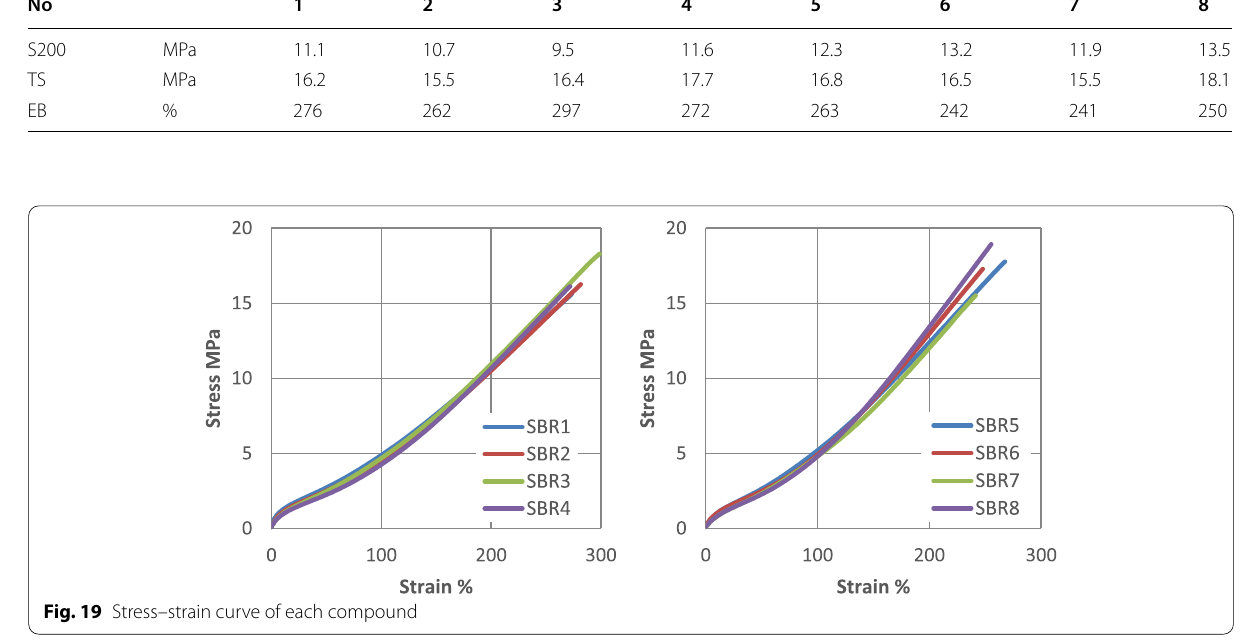
Fig. 19 Stress–strain curve of each compound